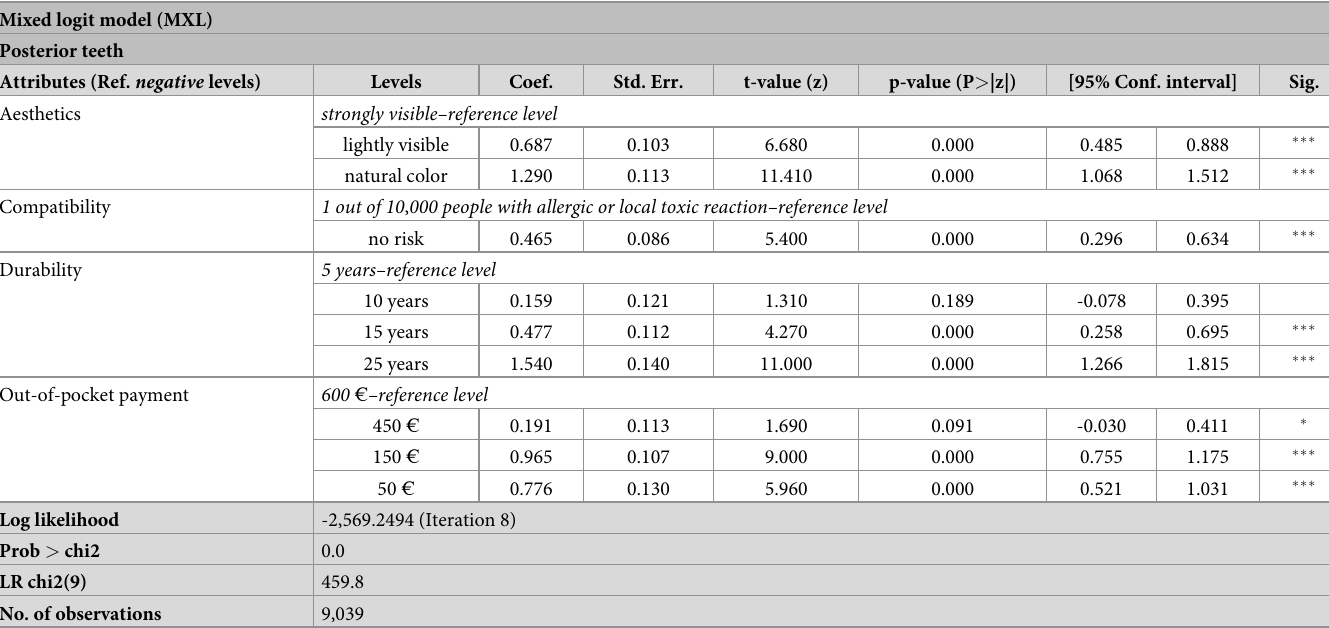
Table 4. Coefficients of the MXL